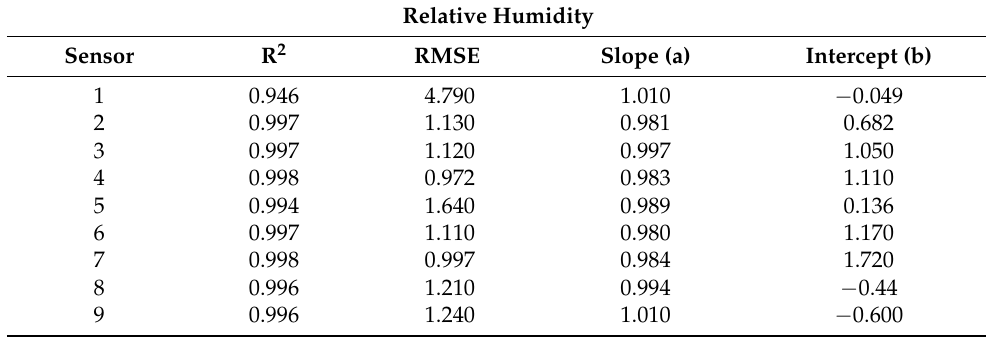
Table 3. Statistical results of the inter-comparison of the Relative Humidity of the GMX500 sensors.